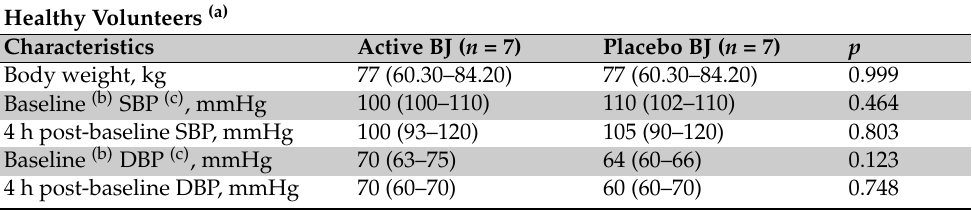
Table 3. Characteristics of healthy volunteers before the ingestion of nitrate-enriched (Active)